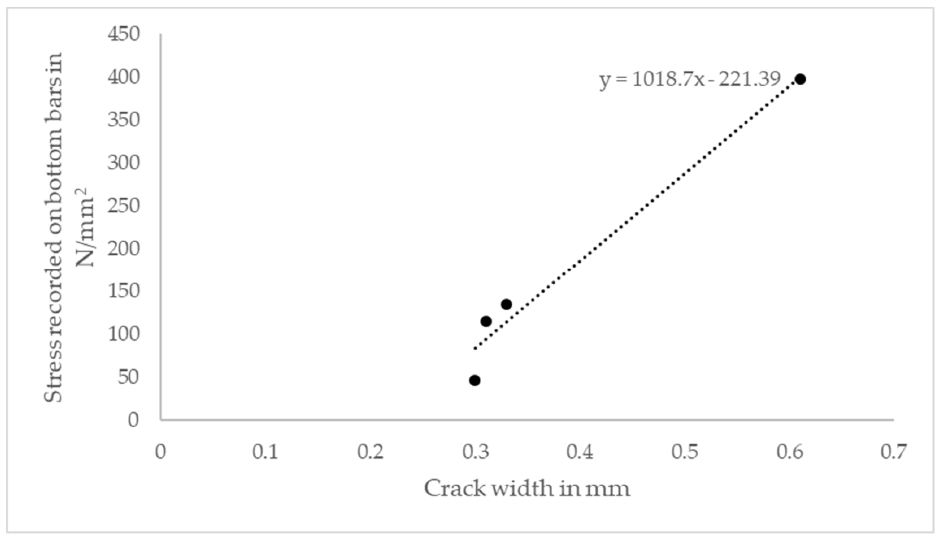
Figure 7. Crack width vs. stress on bottom GFRP bars at 150 kN load.